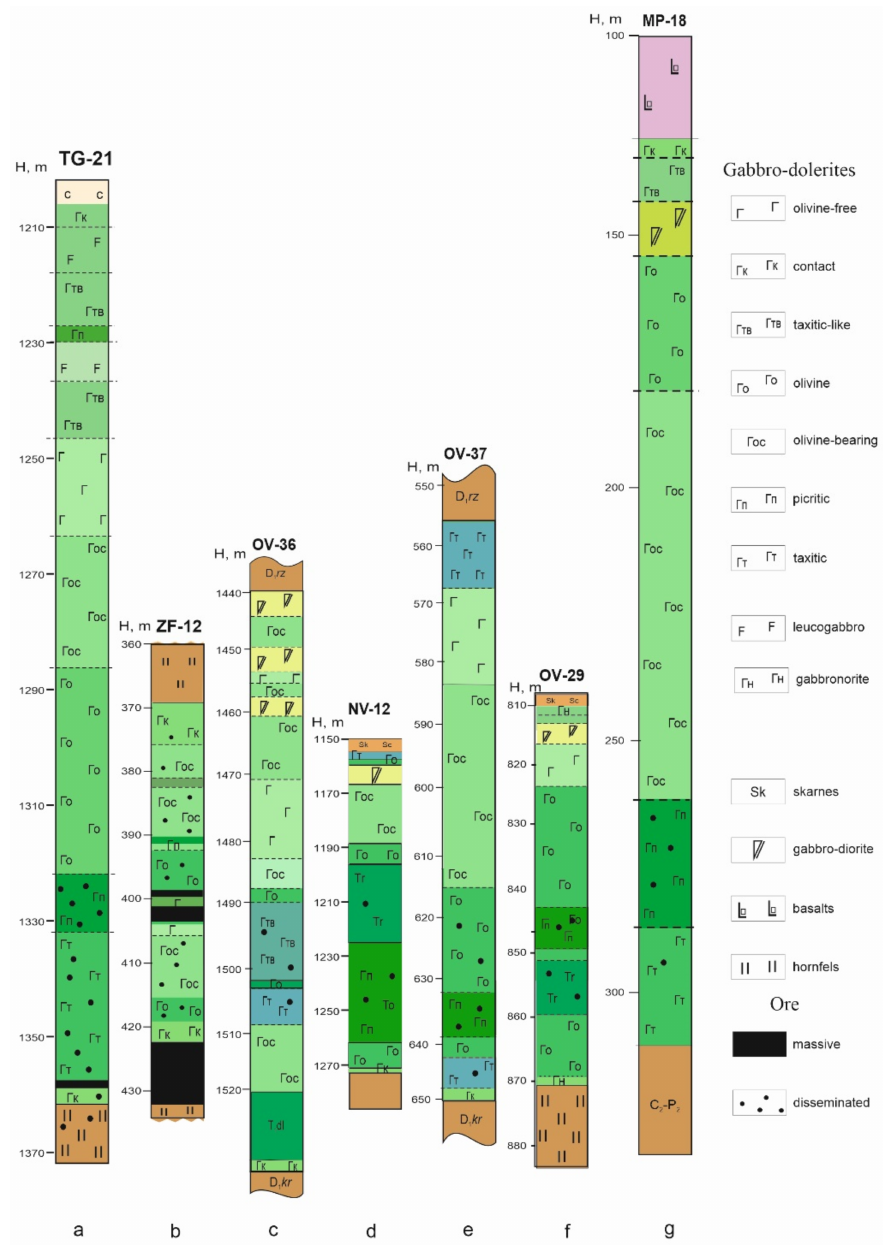
Figure 7. Internal structure of the intrusions in the studied drillholes: ( a ) Kharaelakh (TG-21, East), ( b ) Kharaelakh (ZF-12, West); Pyasinsky-Vologochansky intrusion, South Pyasinsky branch, ( c ) OV- 36 (West), ( d ) NV-12 (Center), ( e ) OV-37 (East); Pyasinsky-Vologochansky, Vologochansky branch, ( f ) OV-29; Norilsk 2 and ( g )